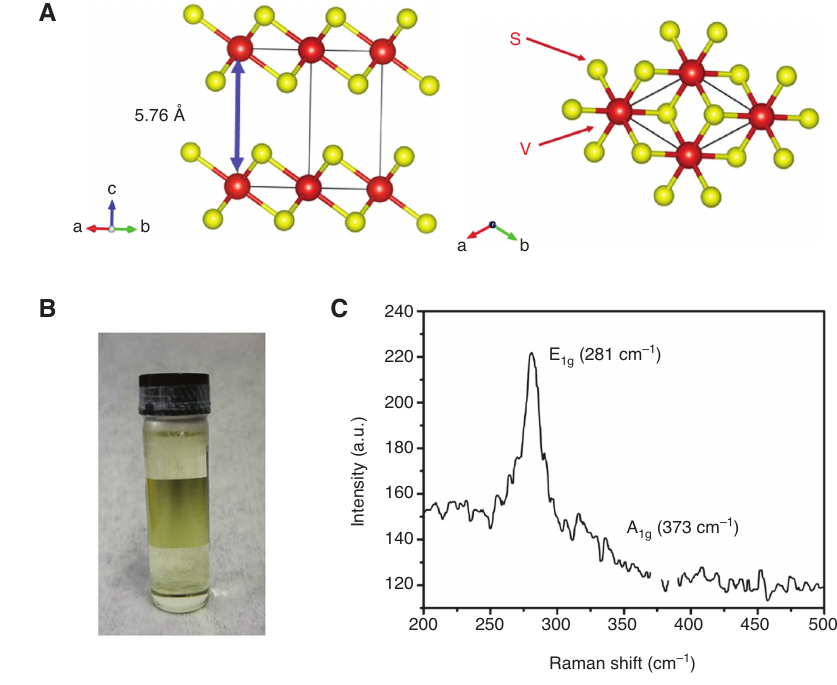
. 2 ; (B) the photograph of VS 2